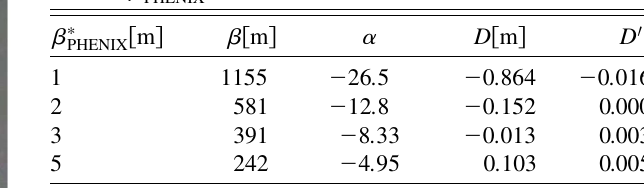
TABLE I. Design horizontal beam parameters at crystal for